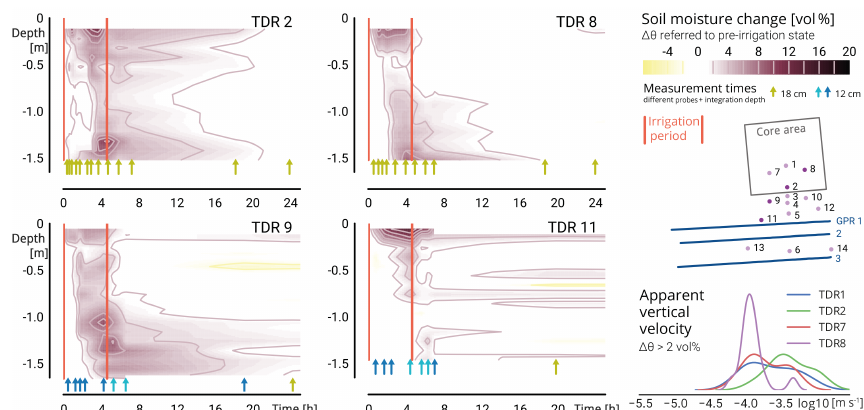
Figure 11. Development of soil moisture in TDR profiles during and after the hillslope irrigation experiment. Exemplary transect with changes referenced to pre-irrigation conditions and attributed to irrigation water. Time is given in hours after irrigation start. Individual measurements and probe reference marked with triangles. More data and explanation in Angermann et al. (2017), this issue. Right bottom: apparent vertical flow velocity as first excess of (cid:49)θ ≥ 2% vol at core area profiles.